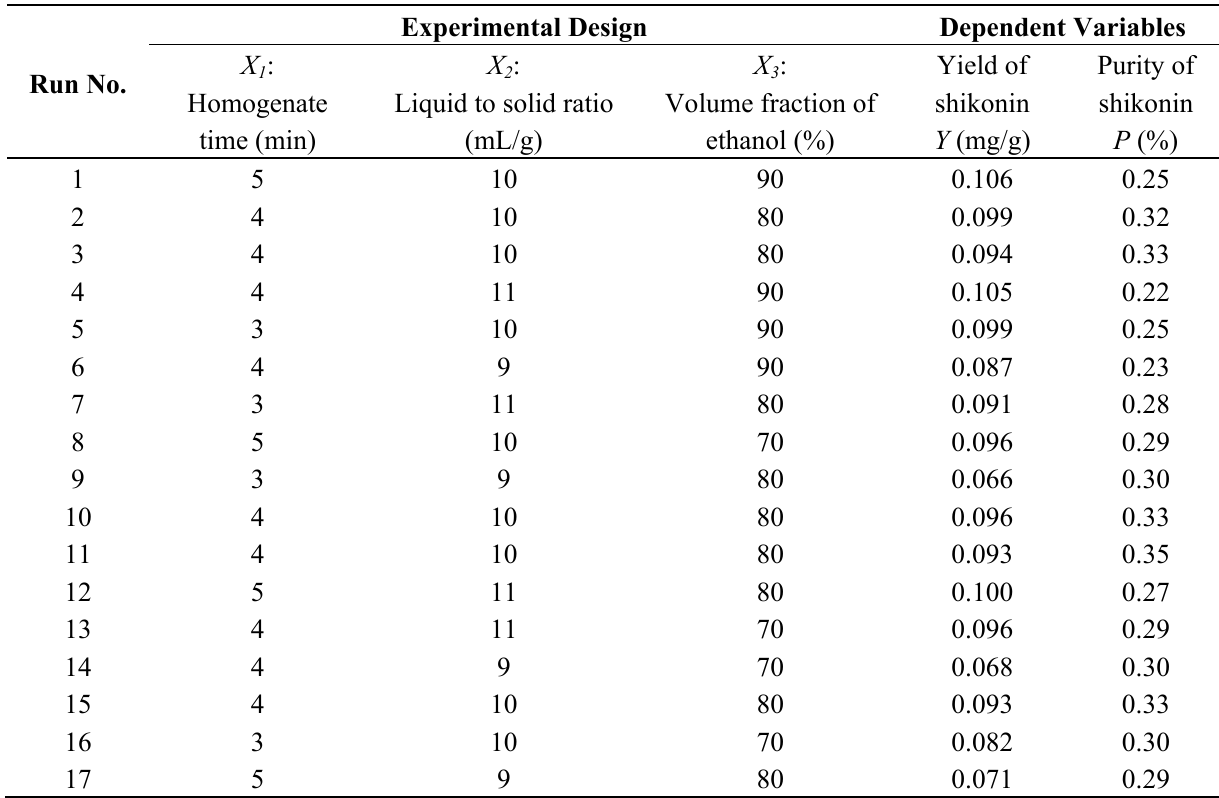
Table 1. Experimental data and the observed response value with different combinations of homogenate extraction time ( X ( X ) used in the Box-Behnken 3